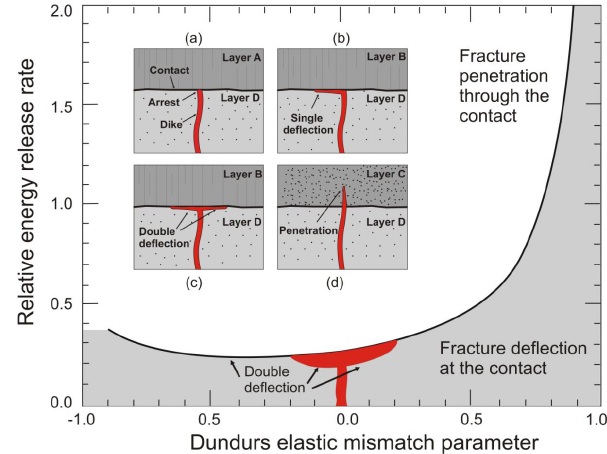
Fig. 9. Ratio of strain energy release rate, a measure of material toughness, to that of Dundurs’ elastic mismatch parameter α D (data from He and Hutchinson, 1998 and Hutchinson, 1996). Inset: on meeting a contact, a fracture (here a dike) may become (a) arrested, (b) singly deflected, (c) doubly deflected, or (d) penetrate the contact. Layers A and B are stiffer than, whereas layer C has the same stiffness as, layer D. With no elastic mismatch across the contact, α D = 0.0 and fracture deflection occurs only if contact toughness is about 25% of the toughness of the layers A, B and C. When the mismatch increases (α D increases from 0.0 toward 1.0), deflection occurs even if the contact toughness becomes higher than the toughness of the adjacent layers.